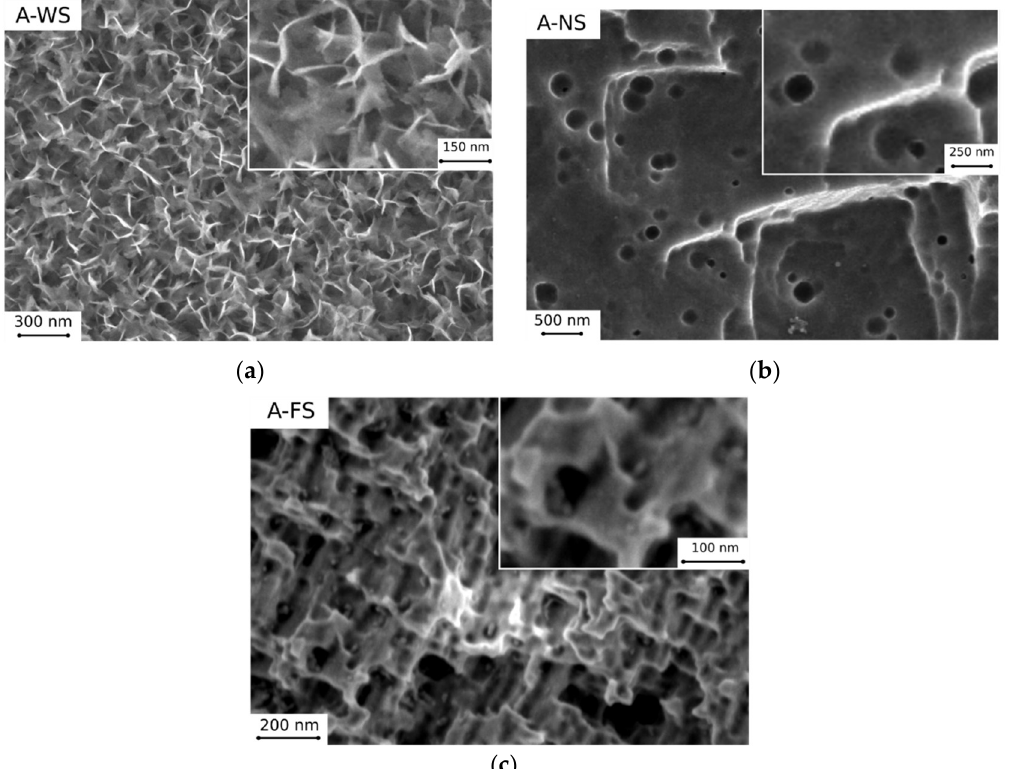
Figure 1. SEM micro-graphs of ( a ) A-WS; ( b ) A-NS, and ( c ) A-FS samples.